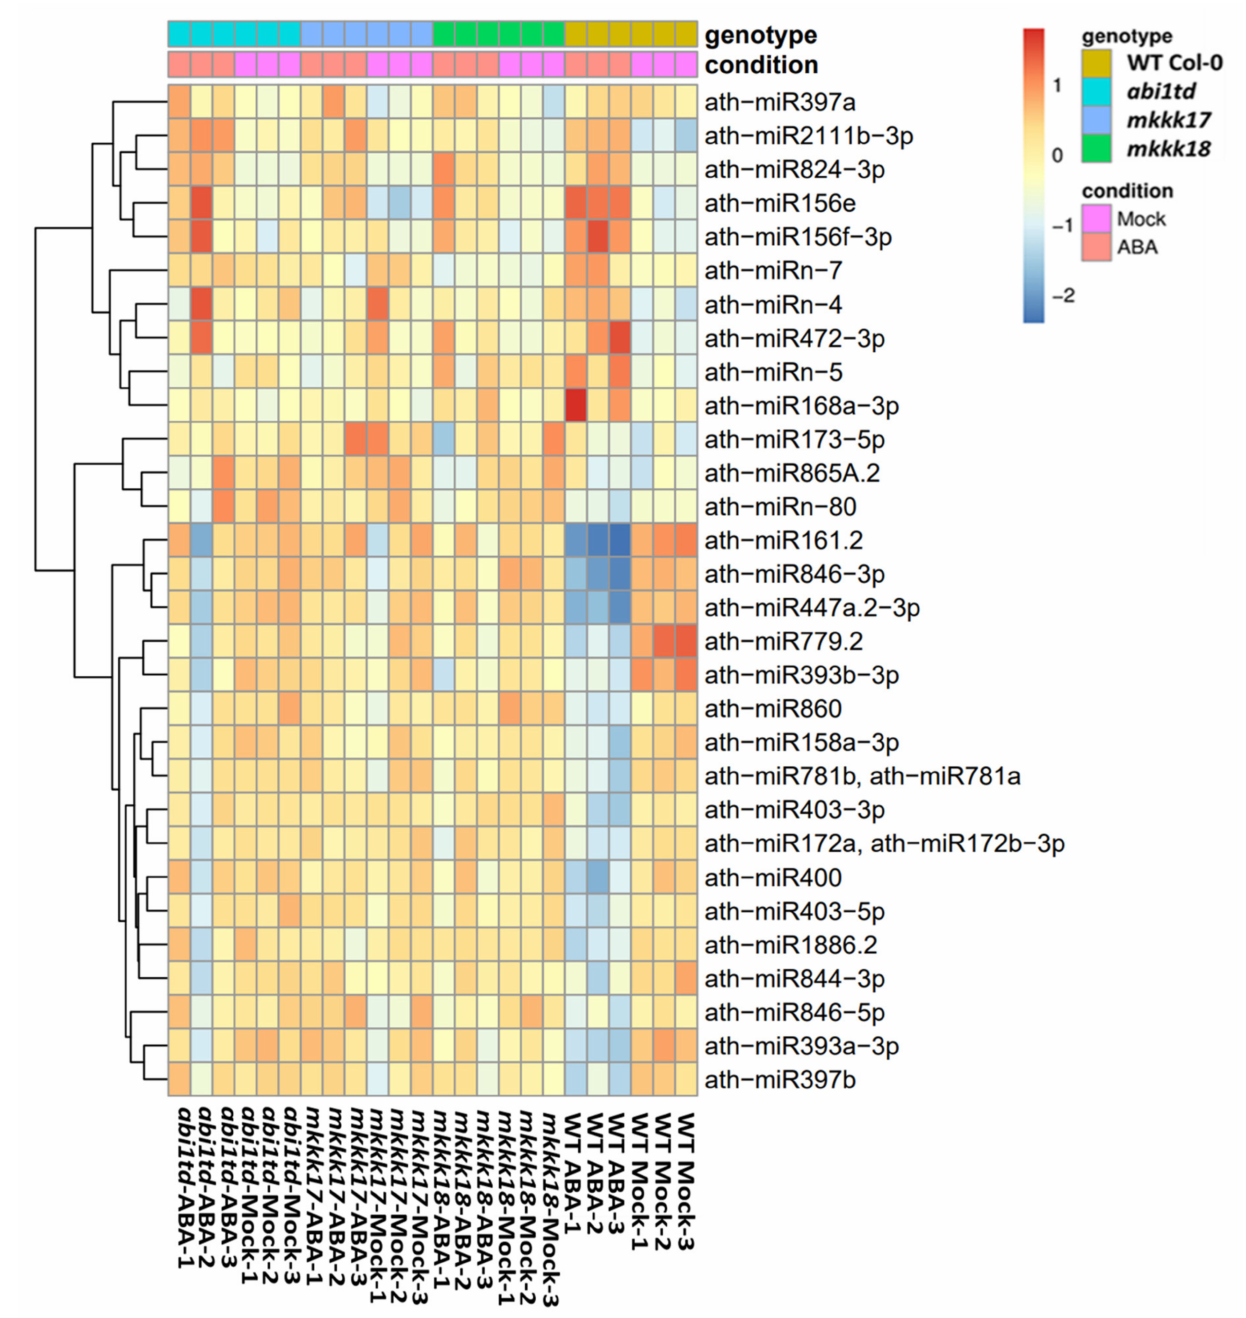
Figure 4. Distribution and expression pattern of known and novel miRNAs in all libraries. The hierarchical clustering analysis by heatmap of ABA-responsive miRNAs from samples of ABA-treated vs. mock-treated Arabidopsis WT Col-0, abi1td , mkkk17 , and mkkk18 mutants. Heatmap showing hierarchical clustering of 30 differently expressed miRNAs are displayed by distance and complete cluster methods as a measurement of similarity from samples of ABA-treated vs. mock-treated Arabidopsis WT Col-0, abi1td , mkkk17 , and mkkk18 mutants. The data in the heatmap are the value of log2 (fold change). Red and blue indicate upregulation and downregulation of miRNAs,